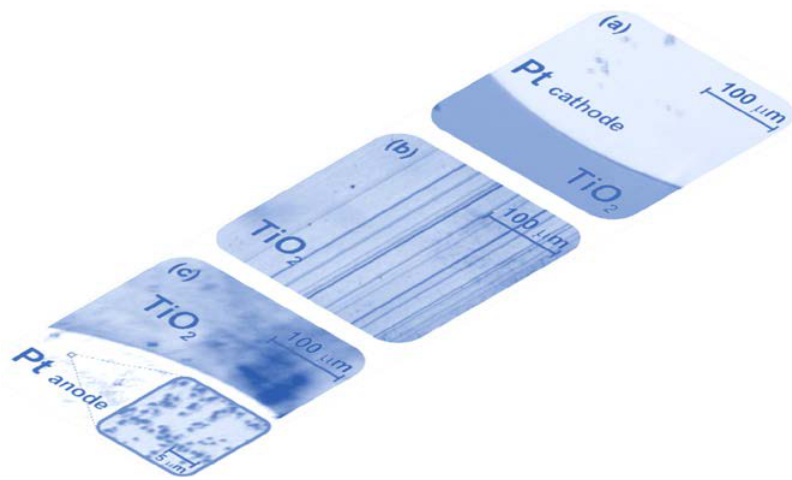
Figure 55. The optical microscope images of the TiO 2 single crystal sample after the electrodegradation process carried out with the setup presented in the left inset in figure 17. The images ( a – c ) show the cathode region, the central region (between the electrodes) with visible parallel stripes (agglomeration of oxygen vacancies) and the anode region with bubble-like changes visible in the magnification in the inset in the ( c ) part. The average dimension of observed bubbles is close to 800 nm. Adapted from [53].